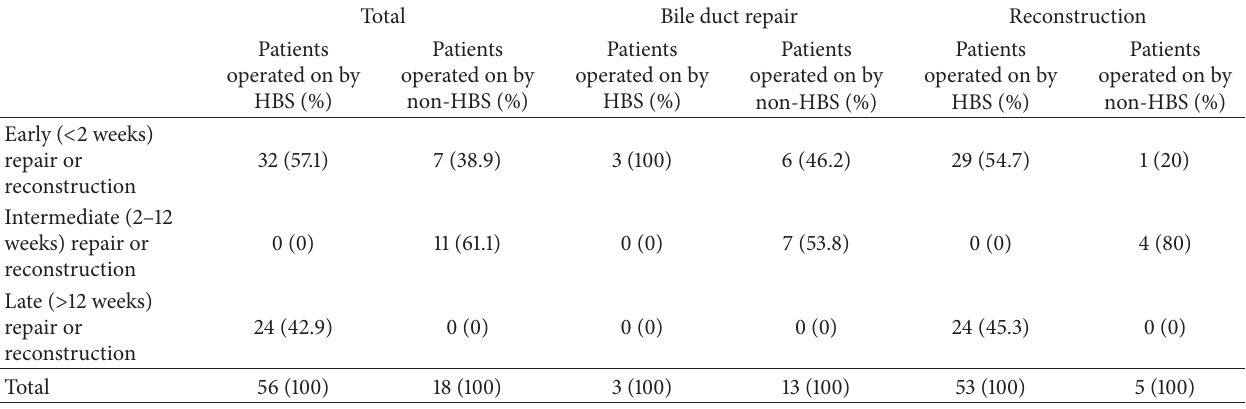
Table 3: Surgical management of bile duct injuries ( 𝑛 =